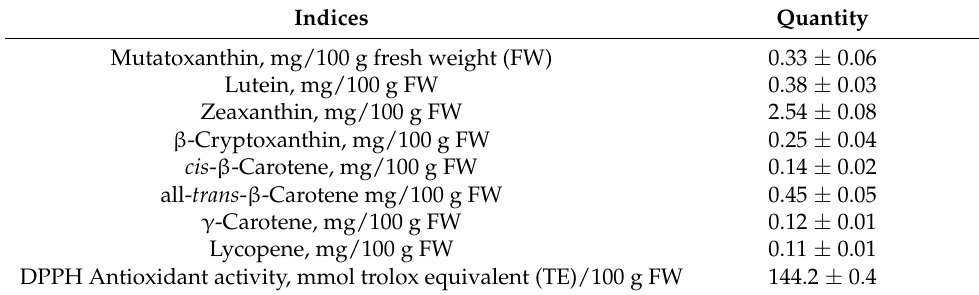
Table 2. The individual carotenoids and the antioxidant activity of sea buckthorn fruit (the results are expressed as means ± standard deviations of three experiments). Indices Quantity Mutatoxanthin, mg/100 g fresh weight